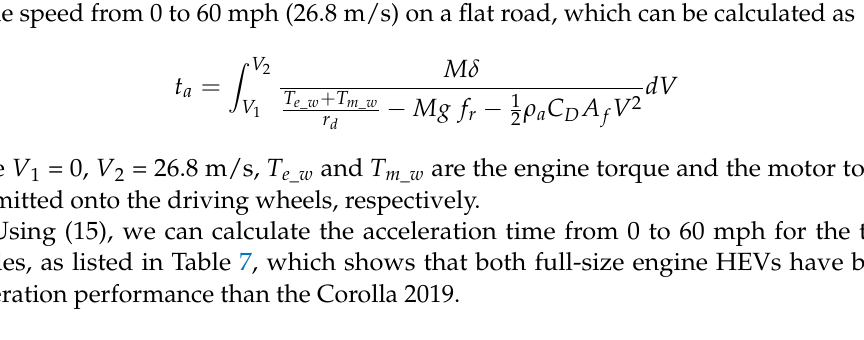
Table 7. Acceleration time from 0 to 60 mph for Corolla-based